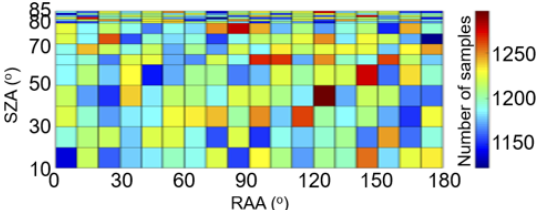
Figure 7. Number of simulations in the evaluation dataset as a func- tion of solar zenith (SZA) angle and relative azimuth angle